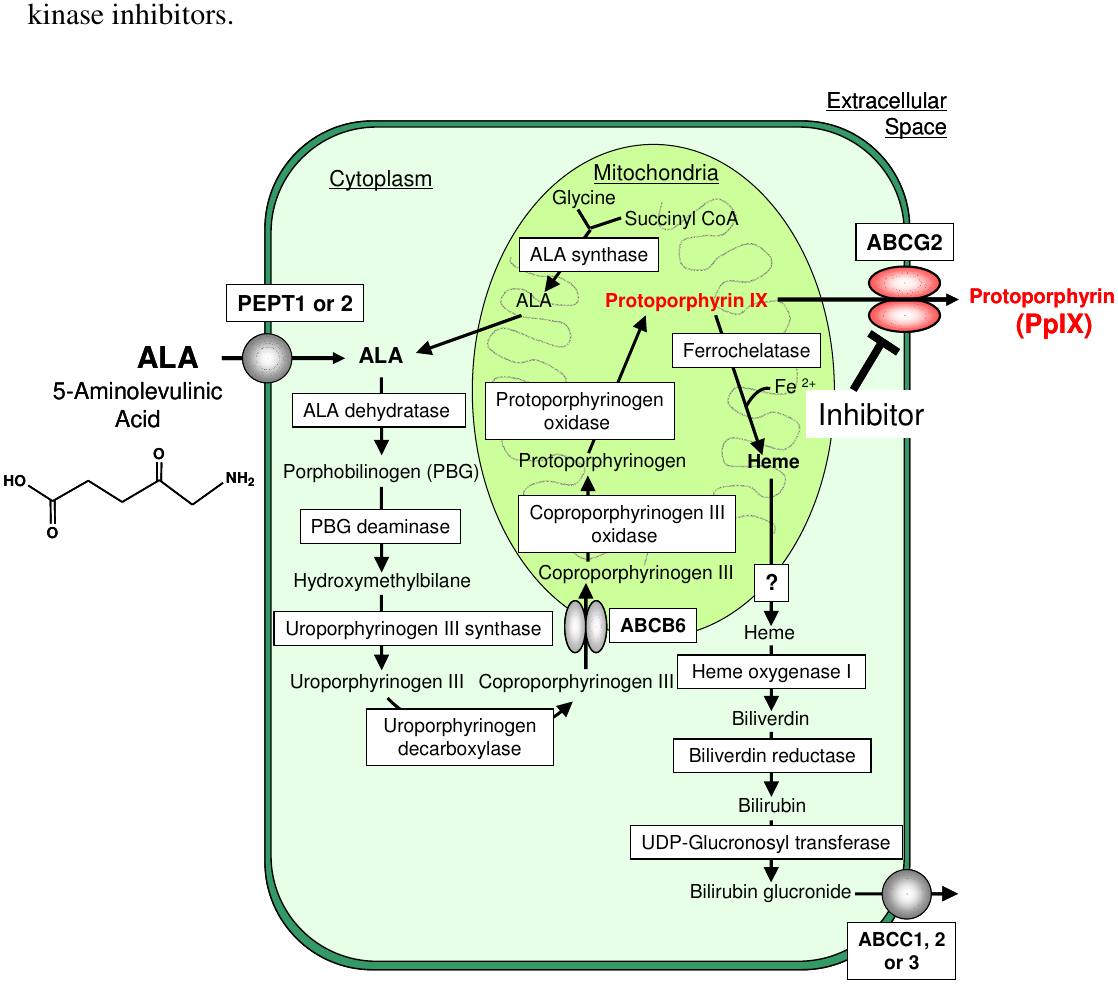
Figure 1. Schematic illustration of the biosynthesis and catabolism of porphyrins and heme. Rectangles indicate the enzymes involved in the metabolism reactions. Porphyrins are synthesized from glycine and succinyl CoA via eight-stepped enzymatic reactions. ALA, γ -aminolevulinic acid; PBG, porphobilinogen. Heme is formed from protoporphyrib IX (PpIX) by the action of ferrochelatase. Heme, thus formed, is catabolized to biliverdin by the microsomal enzyme heme oxygenase 1. Biliverdin is subsequently metabolized to bilirubin by biliverdin reductase. ABC transporters ABCC1, ABCC2, and ABCC3 play